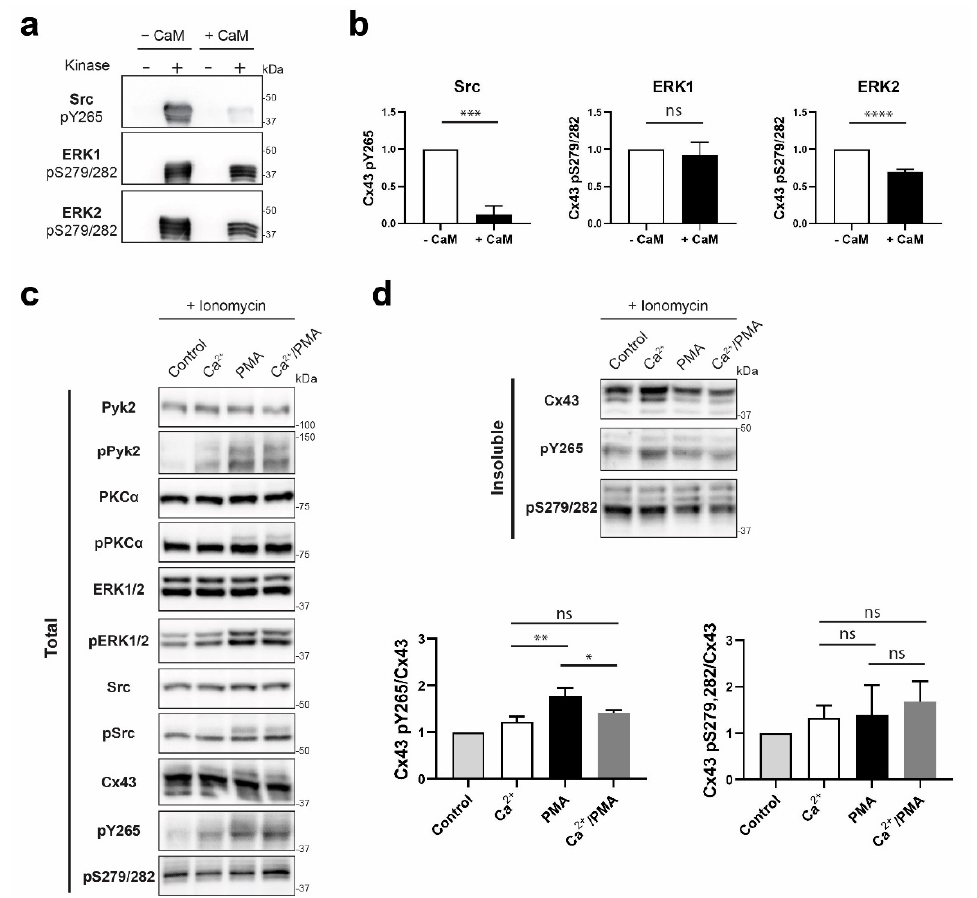
Figure 9. Determining if the CaM interaction with Cx43CT affects MAPK and Pyk2/Src phosphorylation of the Cx43CT domain. ( a ) Src, ERK1, or ERK2 were used in an in vitro kinase assay performed with purified GST-Cx43CT 236-382 as substrate, in presence or absence of CaM. Phosphorylation was detected by Western blot using Cx43 Y265 or S279/S282 phospho-specific antibodies. ( b ) Quantification of the phosphorylation level from three independent experiments using Figures the iBright Analysis Software and analyzed in GraphPad Prism 8.0 (Student’s t-test, *** p < 0.0005 , ****p < 0.0001 ). HeLa Cx43 cells were treated with ionomycin and Ca 2+ , or PMA, or Ca 2+ /PMA for 30 min. Lysates were then subjected to Triton X-100 extraction. Total lysate ( c ) and insoluble ( d ) fractions were analyzed by Western blot. Antibodies used are labeled on the left of each panel. Quantification of the Cx43 pY265 and pS279/282 phosphorylation levels were obtained from three independent experiments using the iBright Analysis Software and analyzed in GraphPad Prism 8.0